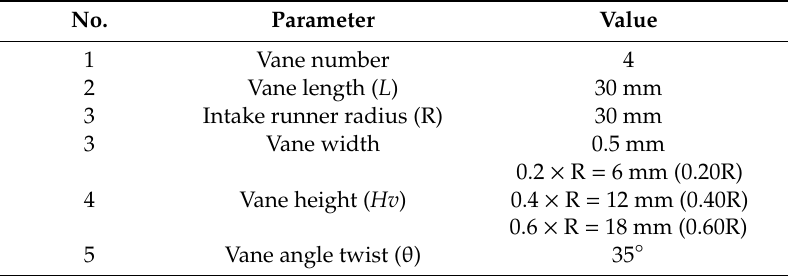
Table 2. Specifications of the installed (GVD).